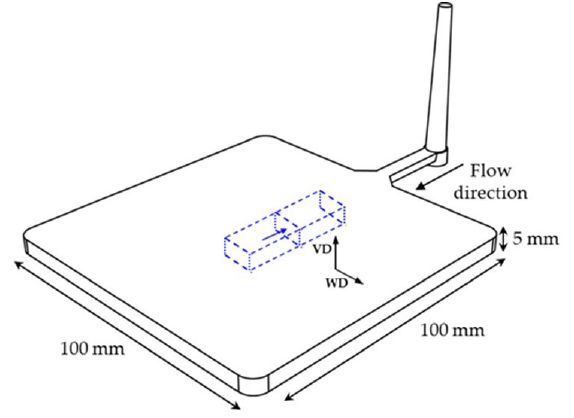
Figure 1. Scheme representing the square-shaped injection-molded part and the sample taken for dynamic-mechanical-thermal analysis (in blue). Blue arrow indicates the surface of the sample taken for the analysis of the cellular morphology of foams by scanning electron microscopy. VD: Vertical direction; WD: Width